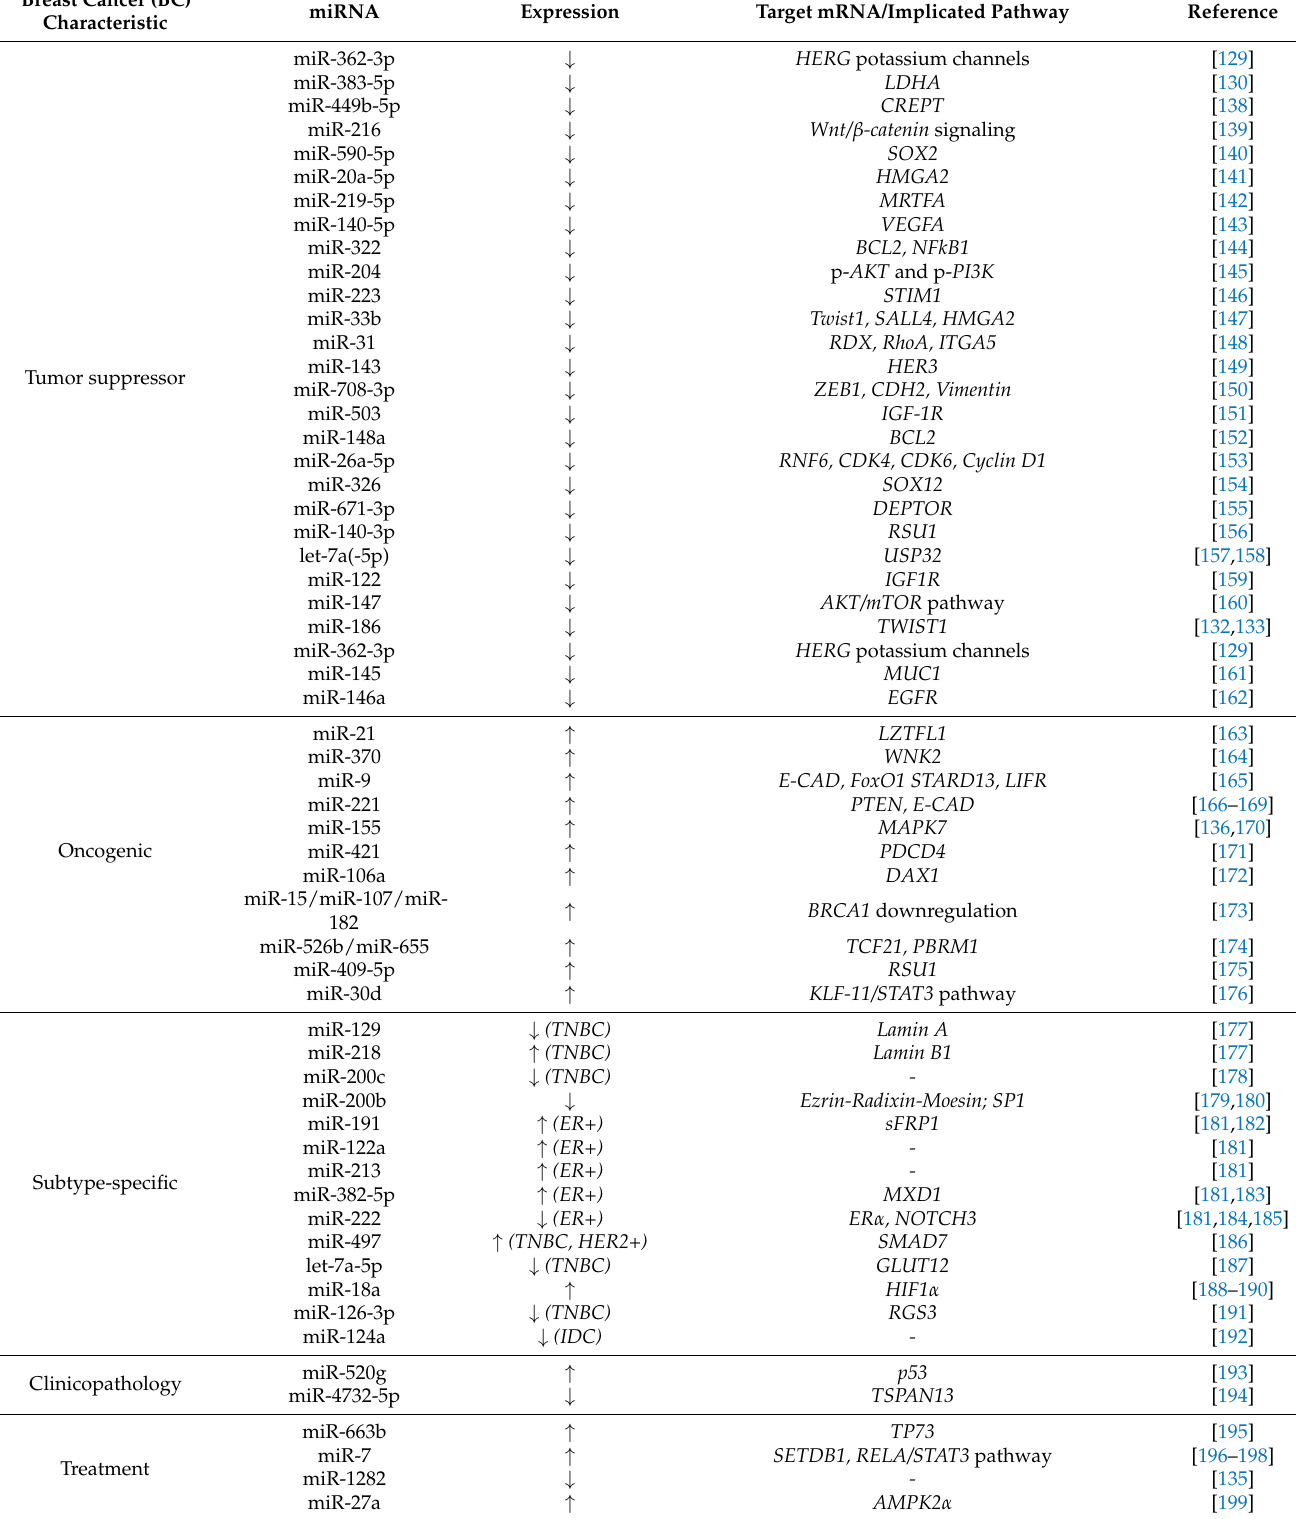
Table 2. miRNA and target gene regulation in breast